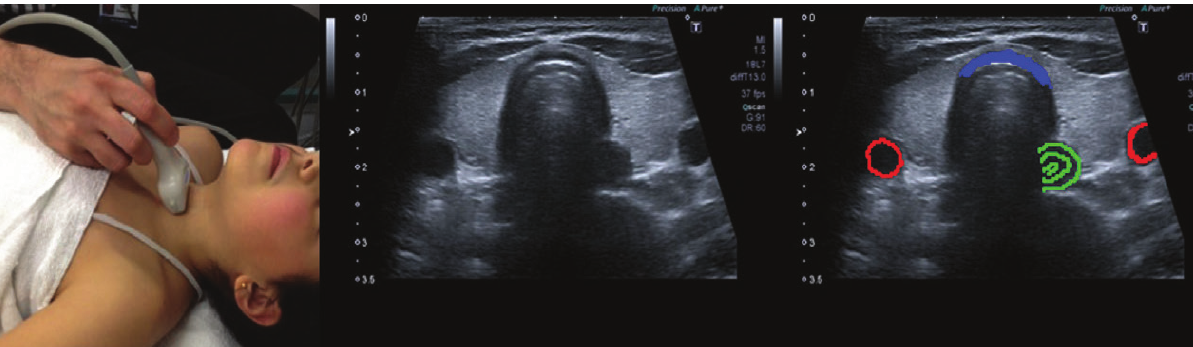
Figure 7. Ultrasound of transverse view of trachea Tracheal ring (blue), oesophagus (green) and carotid arteries (red) 29